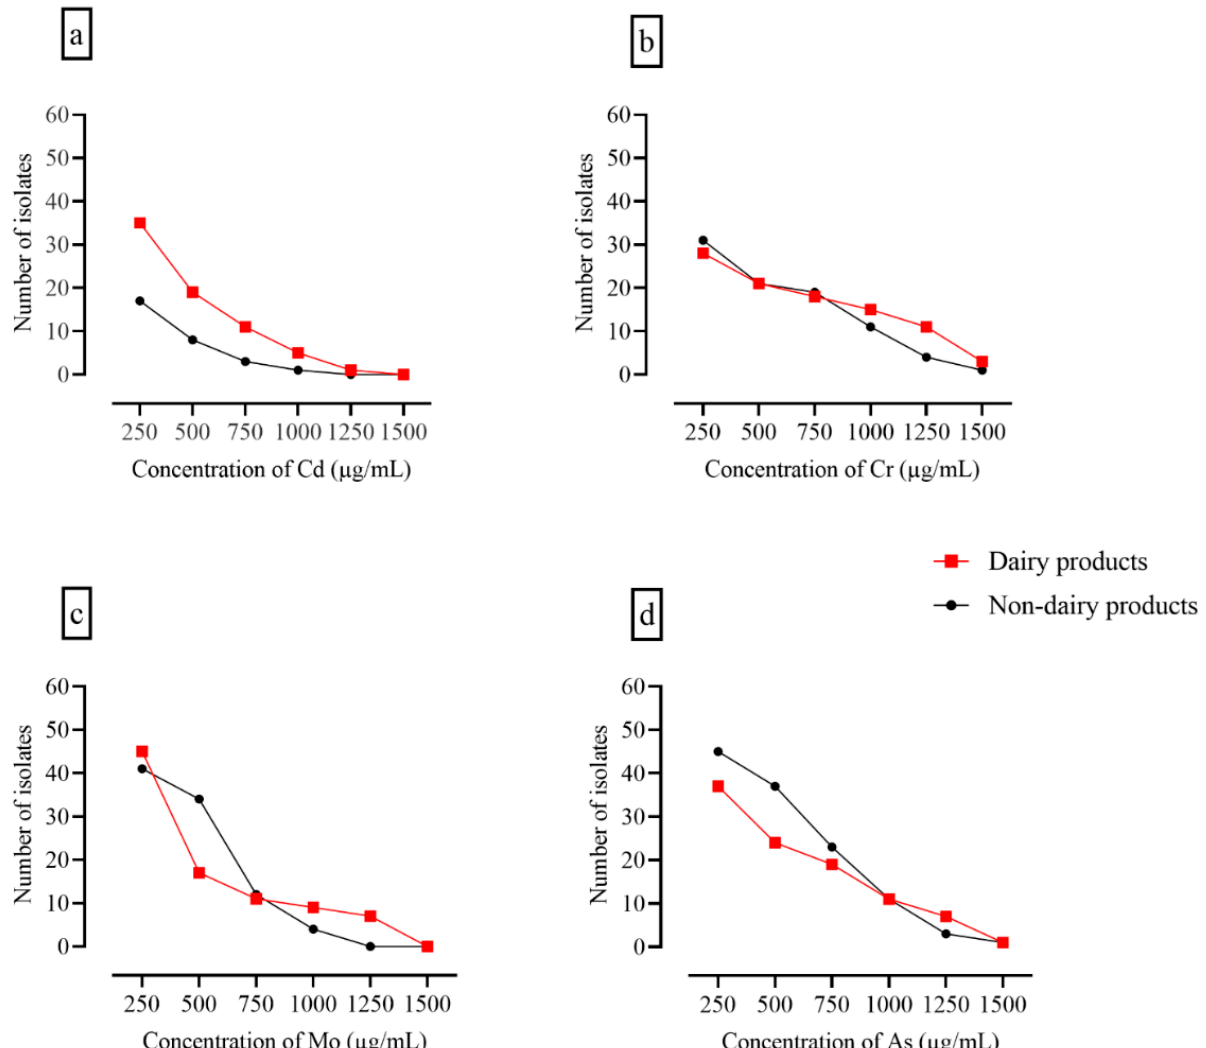
Figure 3. Number of isolates at different concentrations of heavy metals. The panels show the effects of heavy metals on the growth of bacteria isolated from dairy and non-dairy products. Several bacterial cultures did not grow at the lowest concentration of heavy metals (250 µg/100 mL) on nutrient agar. The culture positivity of surviving bacteria grown at the lowest concentration of heavy metals declined with increasing concentrations of; ( a ) Cd: cadmium chloride; ( b ) Cr: chromium oxide; ( c ) Mo: molybdenum oxide; and ( d ) As: arsenic chloride.